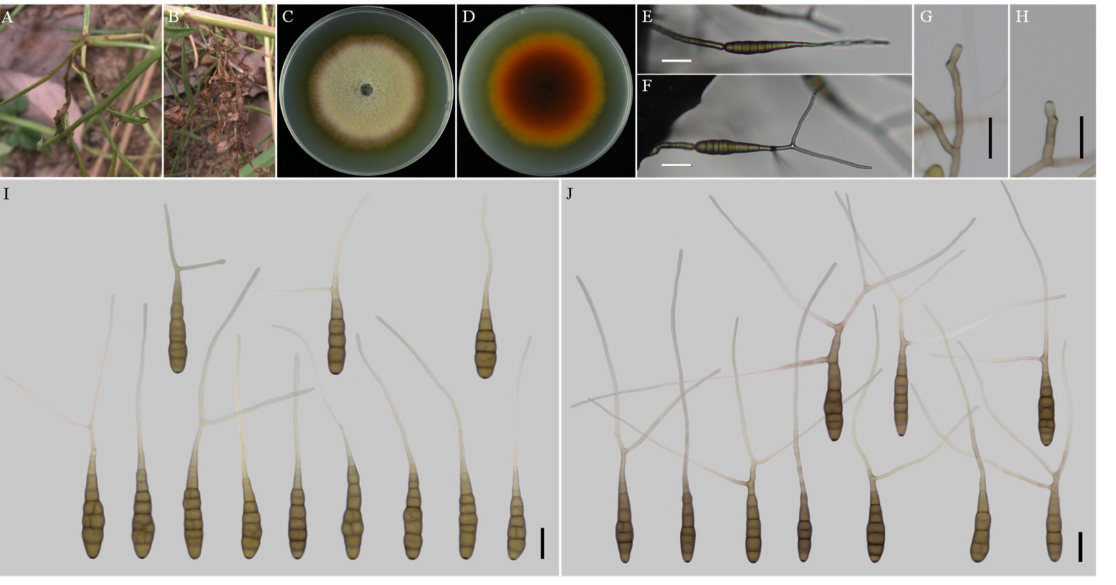
Figure 2. Morphology of Alternaria anhuiensis sp. nov. ( A , B ) Natural symptoms of Coreopsis basalis ; ( C , D ) Colony phenotypes (on PDA for 7 days at 25 ◦ C); ( E , F ) Sporulation patterns (on V8A at 22 ◦ C); ( G , H ) Conidiophores (on V8A at 22 ◦ C); ( I ) Conidia (on V8A at 22 ◦ C); ( J ) Conidia (on PCA at 22 ◦ C). Bars: ( E – J ) = 25 µ m.